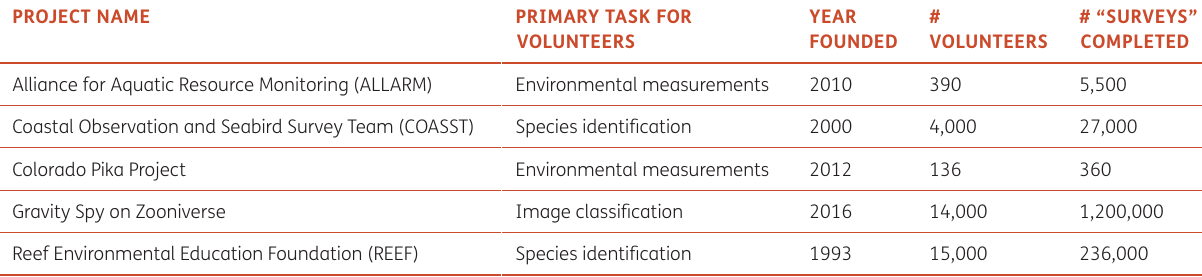
Table 1 Description of our five project partners at the beginning of our